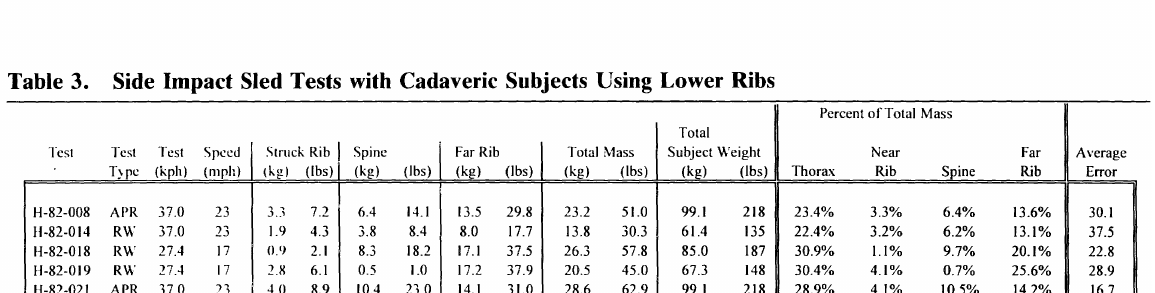
Percent of Total Mass rotal